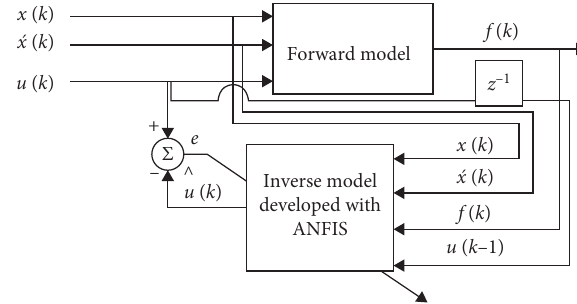
Figure 4: The MR damper inverse modeling using ANFIS tech- nique